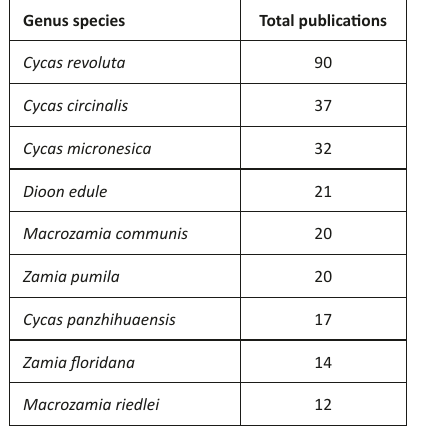
Table 1. The top 10 cycad species with the most publications from Google Scholar search methods. Genus